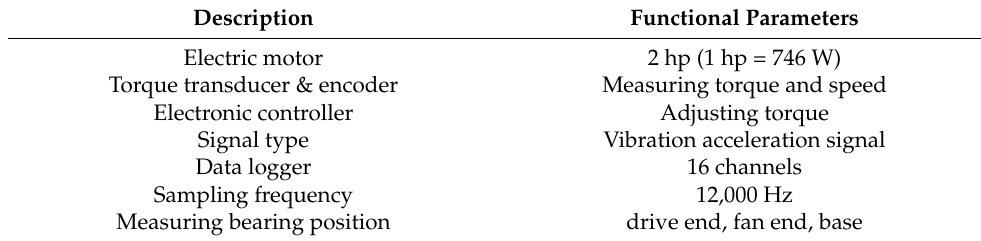
Table 3. Test fault setting.